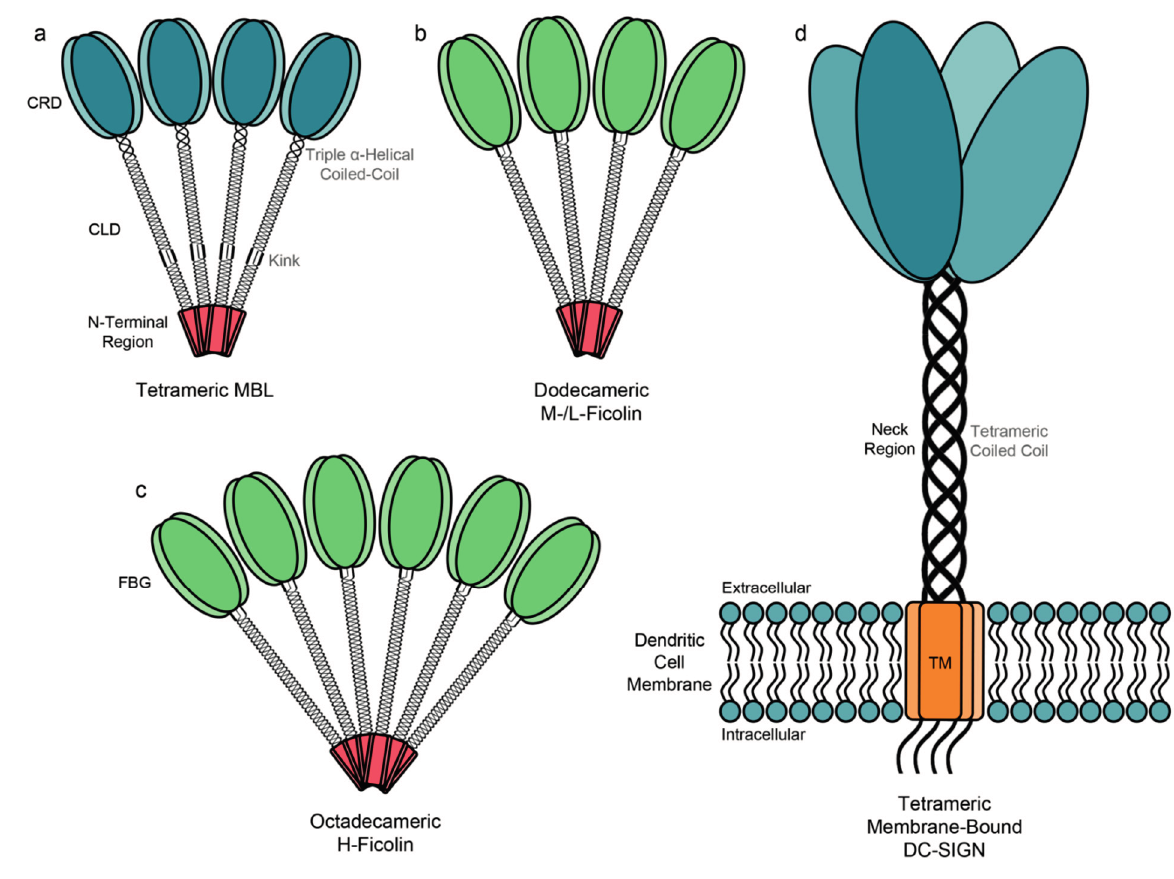
Figure 3. Active, oligomeric structures of ( a ) MBL; ( b ) M-/L-ficolin; ( c ) H-ficolin; ( d ) DC-SIGN. MBL and DC-SIGN possess C-terminal carbohydrate-recognition domains (CRD) whereas ficolins possess fibrinogen-like domains (FBG). MBL and ficolin